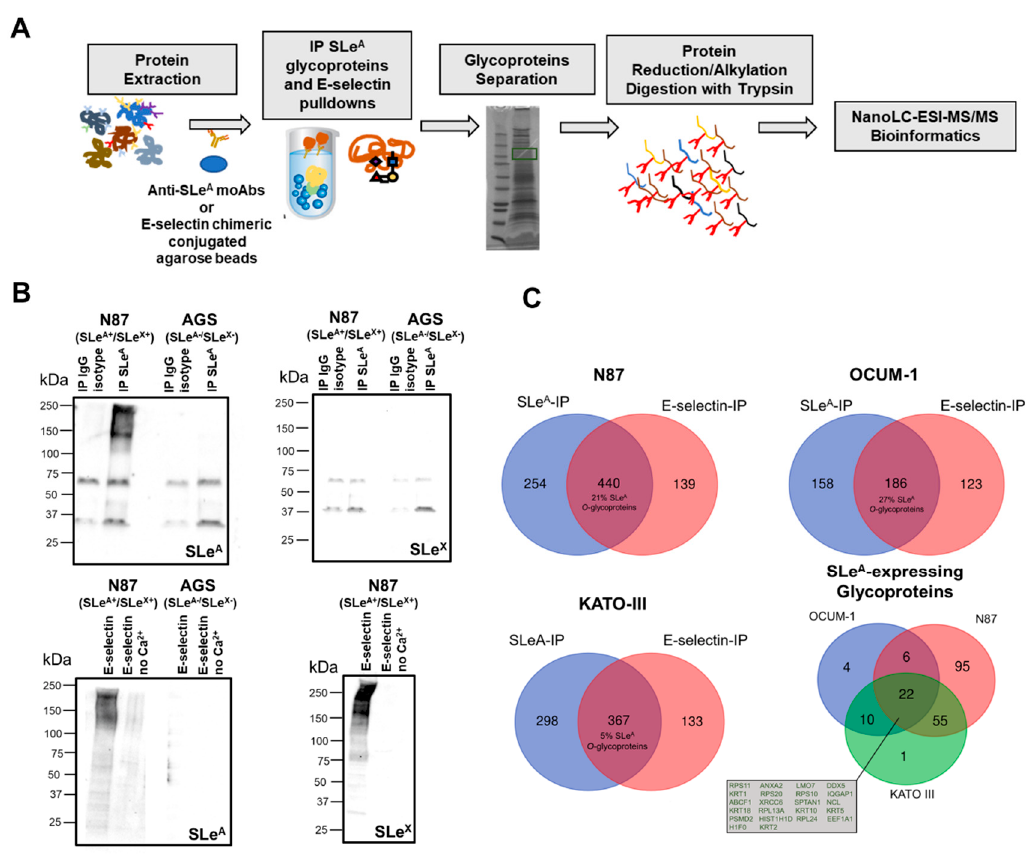
Figure 3. ( A ) Schematic representation of the workflow used to identify SLeA-expressing glycoproteins with affinity for E-selectin. Briefly, IPs with a monoclonal targeting the SLeA antigen were used to isolate glycoproteins from plasma membrane glycoproteins enriched extracts. In parallel, samples were pulled down with E-selectin. Parallel IPs with isotype controls and lectin pulldowns in the absence of Ca 2+ ions (required for binding) were also performed as negative controls. The proteins were then resolved by SDS-PAGE, the bands were excised, proteins reduced, alkylated and digested with trypsin prior to analysis by nanoLC-ESI-MS/MS. ( B ) SLeA and SLeX expressions in glycoproteins obtained by IP for SLeA and corresponding isotype controls for N87 (SLeA+/SLeX+) and AGS (SLeA-/SLeX-; negative control) as well as glycoproteins with affinity for E-selectin in the presence and absence of Ca2+ (negative control). Collectively, the blots support the affinity of the IP strategy for SLeA-expressing glycoproteins with no contaminations from SLeX glycoproteins. On the other hand, E-selectin isolated both SLeA and SLeX expressing glycoproteins. ( C ) Venn diagrams highlighting the distribution SLeA-expressing glycoproteins and glycoproteins showing affinity for human E-selectin for cell line N87 ( A ), OCUM-1 ( B ), and KATO-III ( C ). Glycoproteins with confirmed O-SLeA expressing glycosites and showing affinity for E-selectin among the three cell models ( D ). The Venn diagrams in panels A–C highlight the number of glycoproteins isolated by IP for SLeA and E-selectin for each cell line, evidencing the percentage of glycoproteins commonly identified for both IPs and showing clear SLeA modifications in O-glycans. Panel C highlights the 22 glycoproteins presenting O-SLeA glycosylation and affinity for E-selectin in all cell lines.